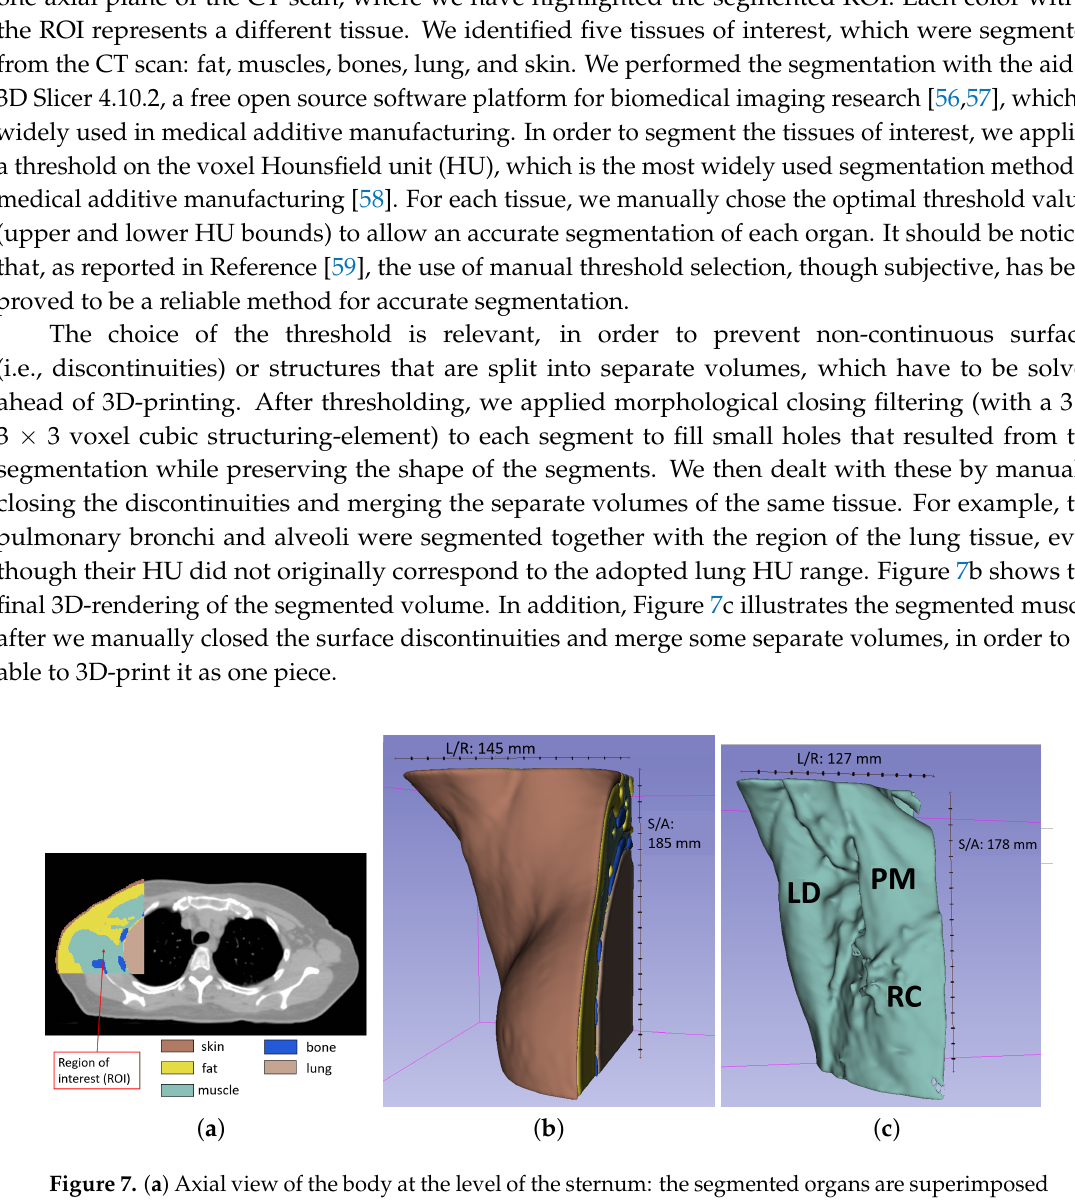
Figure 7. ( a ) Axial view of the body at the level of the sternum: the segmented organs are superimposed to the original Computed Tomography (CT). Each tissue is represented by a different color (legend). The red arrow points at the segmented region of interest. ( b ) 3D-rendering view in 3D-slicer of the segmented organs. ( c ) 3D-rendering view in 3D-slicer of the segmented muscle tissue. Different muscles of the region are indicated: pectoralis major (PM), latissimum dorsi (LD), and rib-cage (RC) muscle. Superior/Anterior (S/A) and Left/Right (L/R) dimensions of the model are